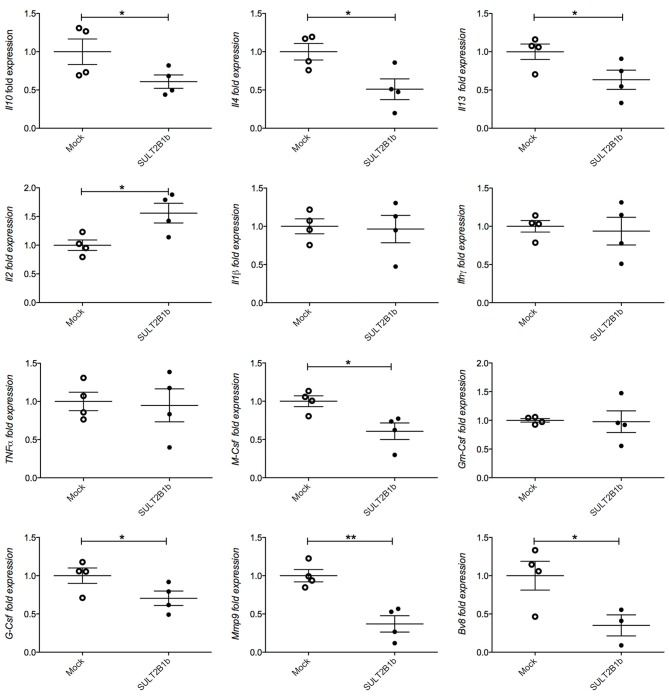
qPCR analysis of cytokines, growth factors, MMP9 and Bv8 transcripts in Mock- and SULT2B1b-4T1 tumors. Tumors were collected 7 days after orthotopic injection in BALB/C animals and subjected to RNA extraction and qPCR analysis. *p < 0.05; **p < 0.01 (Student's t-test).